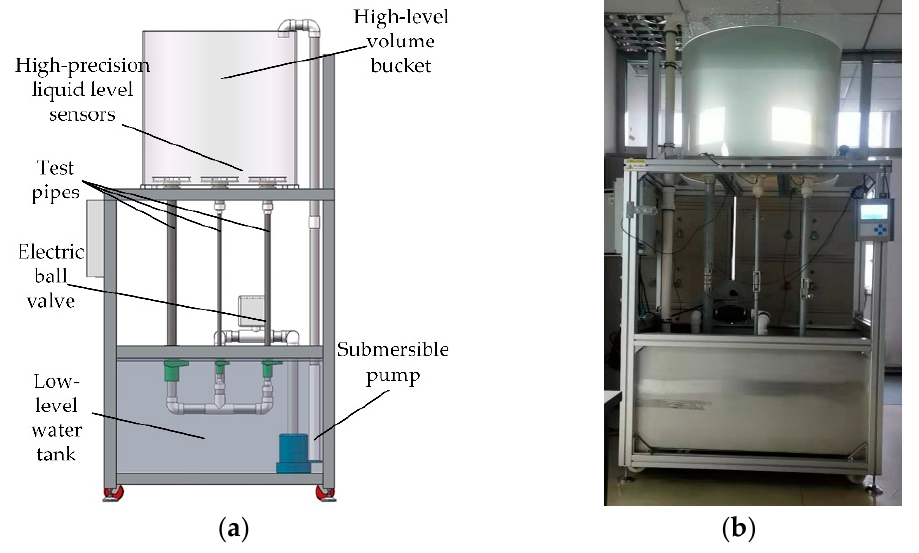
Figure 17. ( a ) Structure diagram of ultrasonic flowmeter test system; ( b ) Physical diagram of ultra- sonic flowmeter test system.